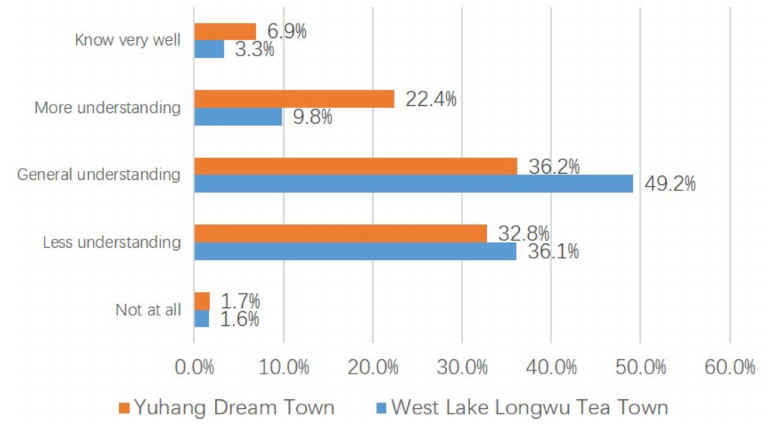
Figure 18. Respondents’ understanding degree of the local CT practice (source: authors).